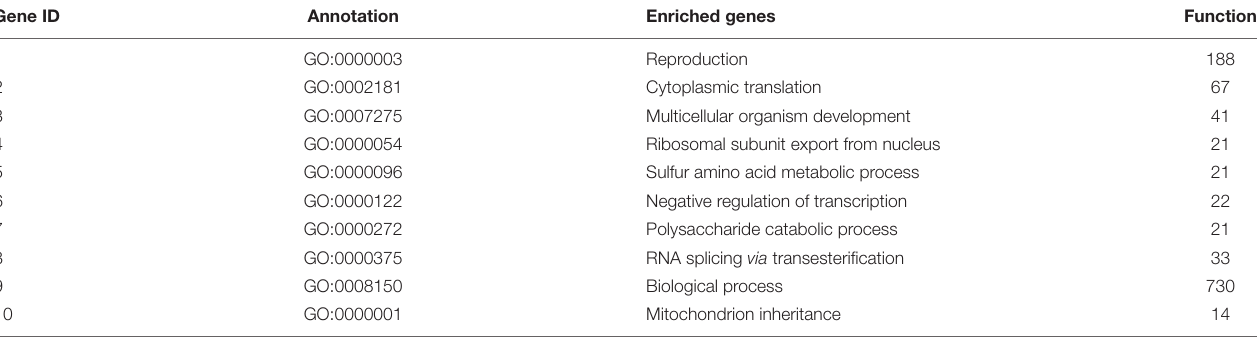
TABLE 6 | Top 10 important enriched GO terms of B. maydis for biological functions differentially expressed in inoculated resistant and susceptible plants.